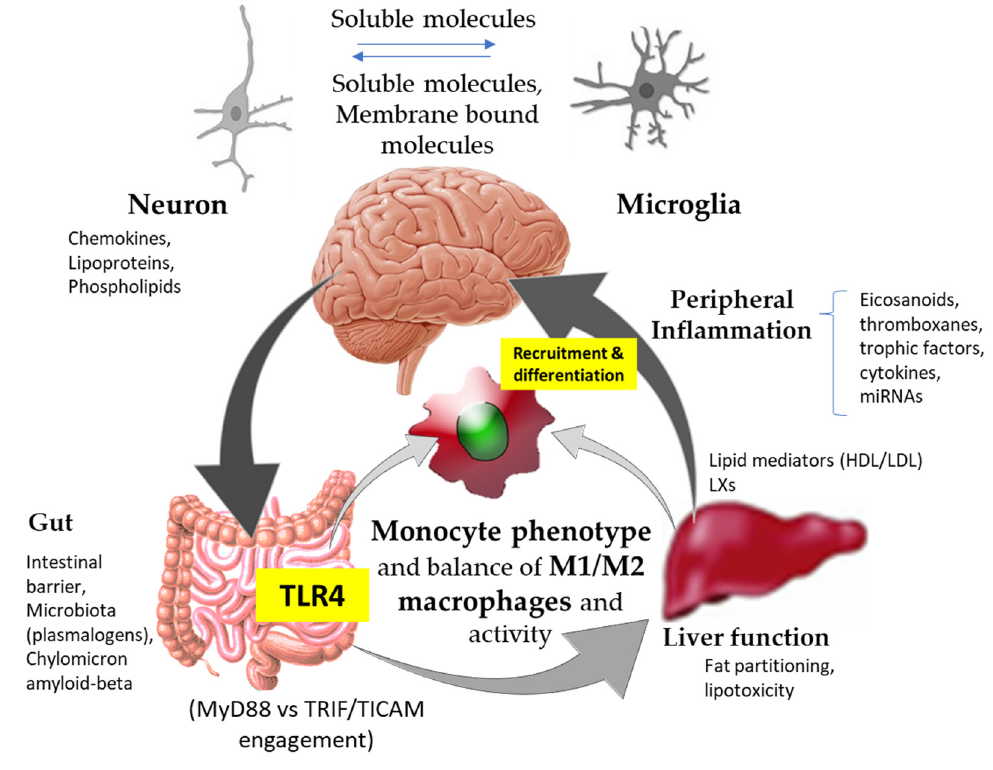
Figure 1. Schematic representation of physiological and biochemical pathways to approach the modifiable factors influencing innate immunity within the gut–liver–brain axis for Alzheimer’s disease prevention and/or treatment. TLR4, innate immune Toll-like receptor (TLR)-4; HDL, high-density lipoprotein; LDL, low-density lipoprotein; LXs, lipoxygenase interaction products.